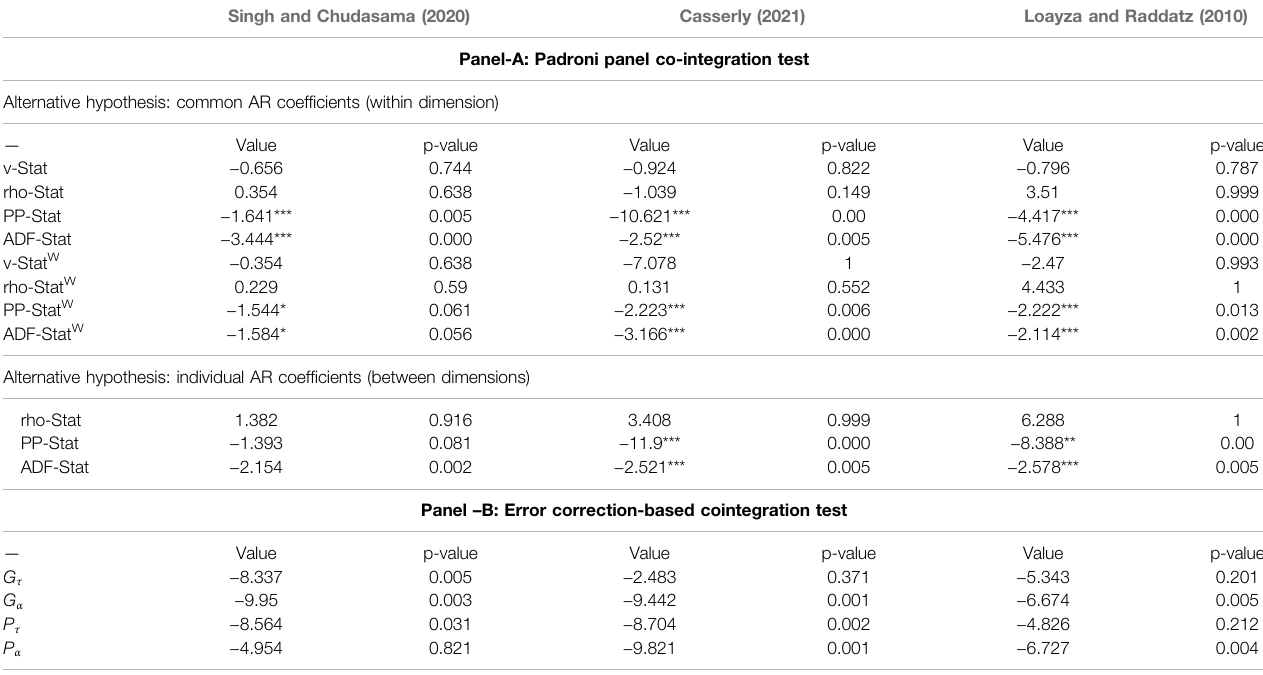
TABLE 8 | Results of panel cointegration tests.